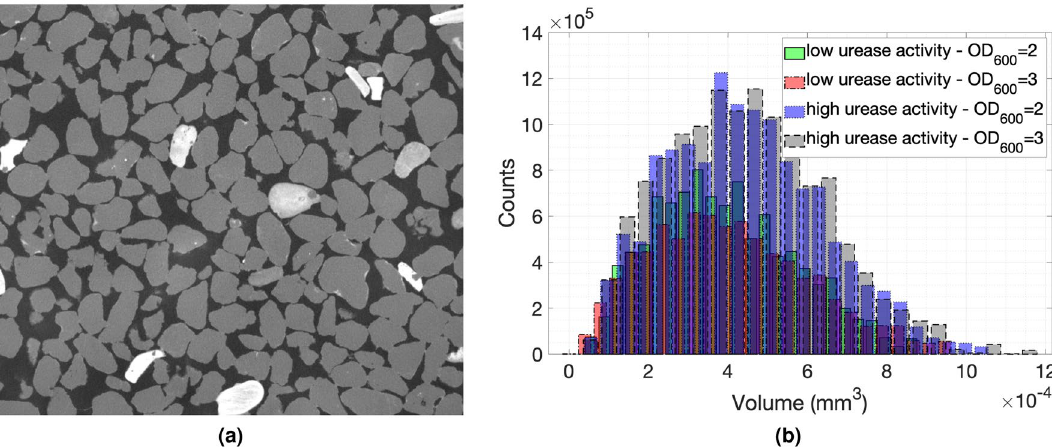
Figure 6. MicroCT imaging: ( a ) A slice of the specimen with its gray values showing the presence of iron minerals, ( b ) The histograms showing the pore network sizes of the specimens with the highest and lowest urease activities (237.4 and 0.45 mmol/L/h, respectively, measured following the standard protocol 1 ) for bacterial populations at OD 600 = 2 and 3. Stacks of images were obtained and transferred to the ImageJ software 52,53 . The images were then binarised and were analysed via the BoneJ plugin 54 to obtain the porosity and distribution of voids 55